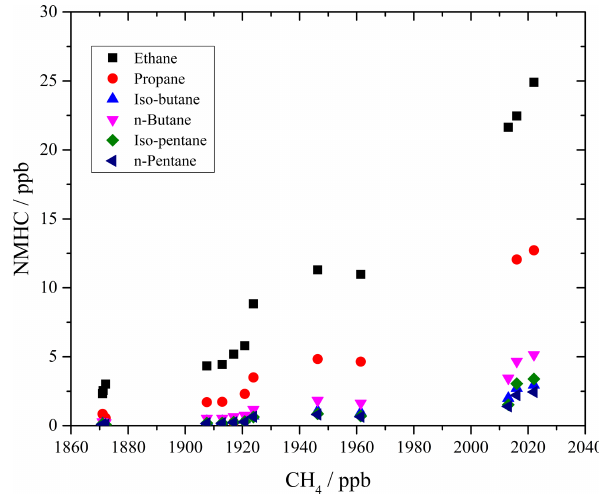
Figure 7. NMHC and CH 4 relationship in Elgin plume samples from three different flights (shown by the different symbols). Data around 1860ppb CH 4 represent typical background mixing